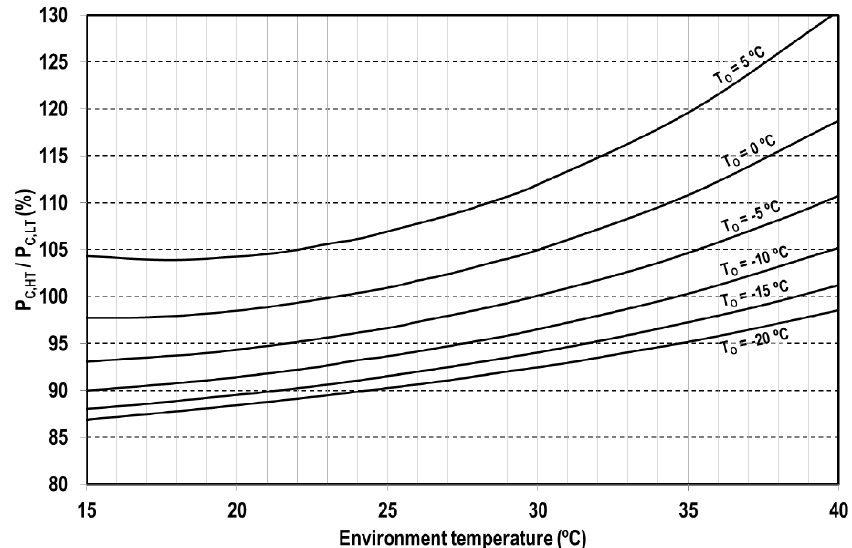
Figure 11. Ratio of compressor’s power consumptions of the cascade cycle.